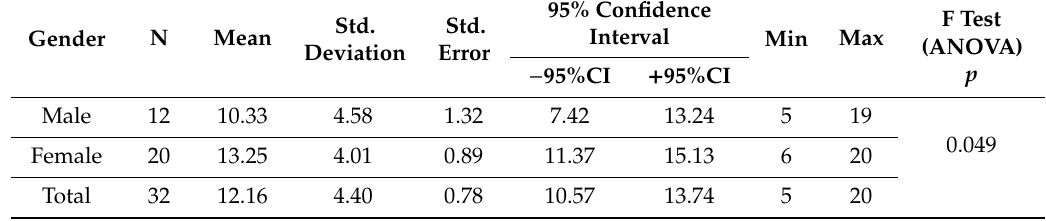
Table 5. Descriptive statistics of emotional functioning score by gender.